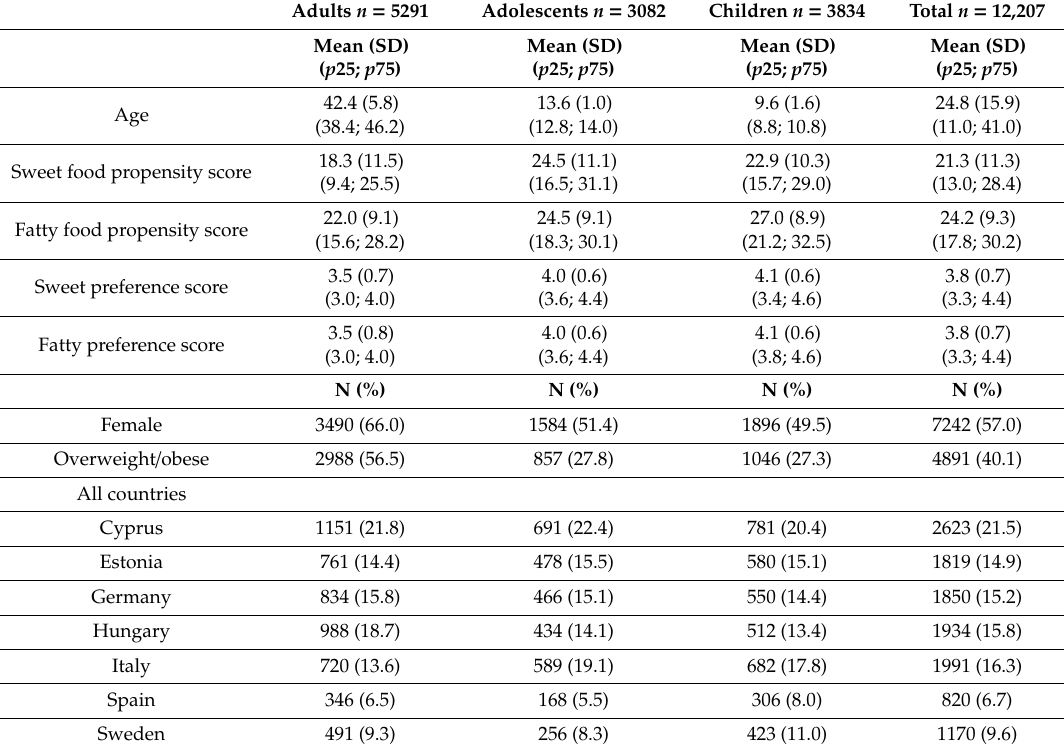
Table 2. Characteristics of the study